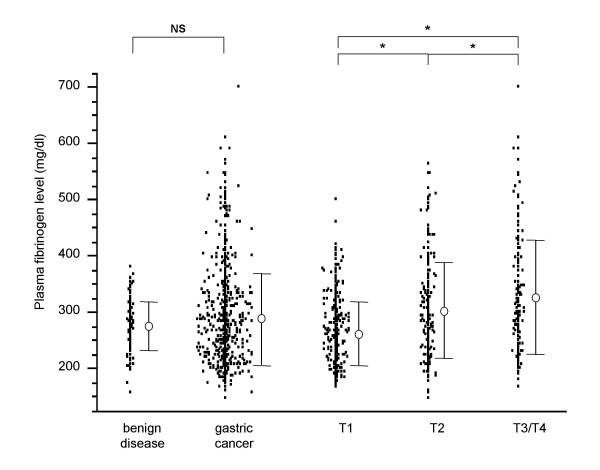
Plasma fibrinogen level of 124 patients with benign disease and 792 patients with gastric cancer. Note that there is no difference in fibrinogen levels between benign and cancer patients, although it gradually increases with increasing depth of cancer invasion (one way ANOVA with SNK test; p < 0.0001). Values are the mean (standard deviation) levels for individual patients. *The mean values of plasma fibrinogen were significantly different between the groups of T1 and T2 (P < 0.01), between the groups of T1 and T3/T4 (P < 0.01), and between the groups of T2 and T3/T4 (p < 0.01).